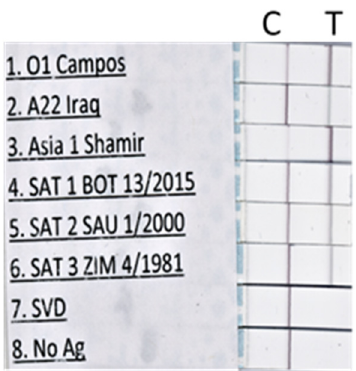
Figure 1. Samples (representative of six foot-and-mouth disease virus serotypes and swine vesicular disease virus) were each mixed with biotinylated recombinant bovine integrin α v β 6 and a gold- conjugated monoclonal antibody (mAb F21-42) in running buffer. A gRAD strip per sample was dipped into the tube containing this mixture which ran through the strip by capillary action, and the results were determined after 10–30 min. A positive result is indicated by visible bands on both the test line (T) and the control line (C). A negative result is indicated by a visible band on the control line only.